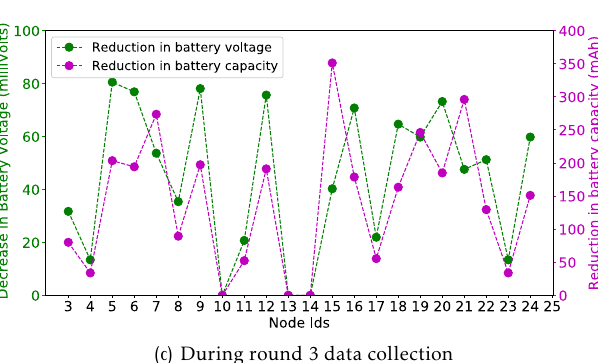
Figure 27. Decrease in battery voltage and the corresponding energy expenditure of nodes - test case 2